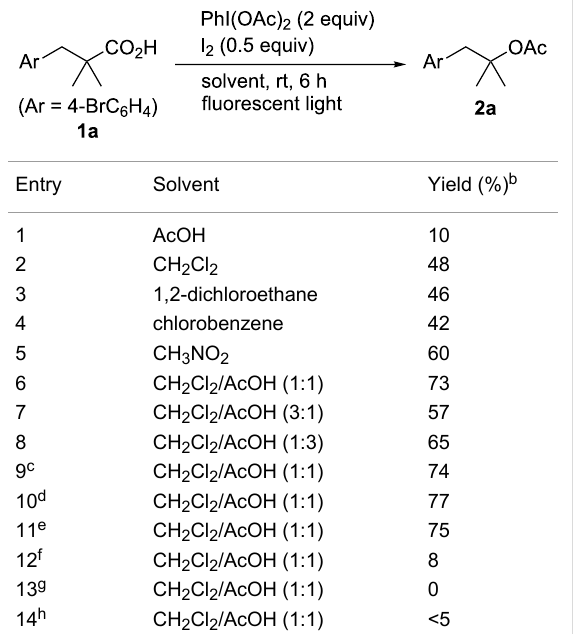
Entry Solvent Yield (%)